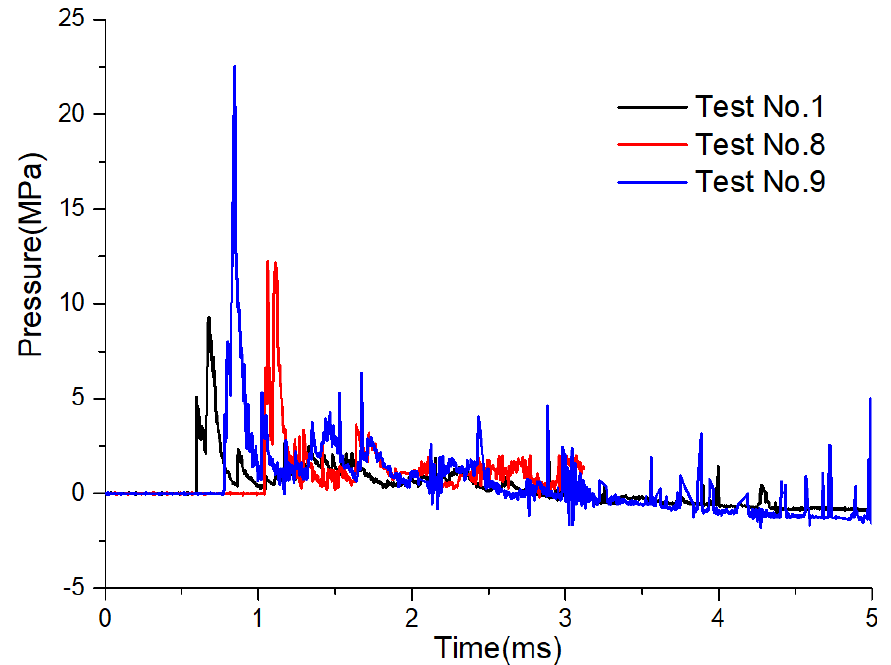
Figure 8. Pressure history under different cases.